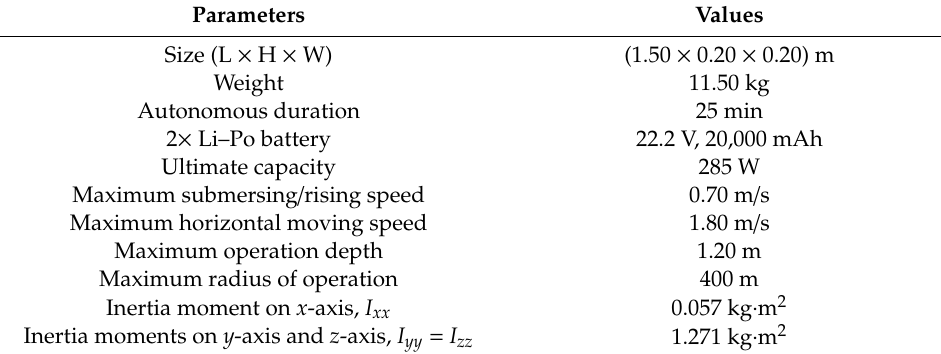
Table 3. The torpedo-shaped AUV’s main operating parameters (data from [63] ).